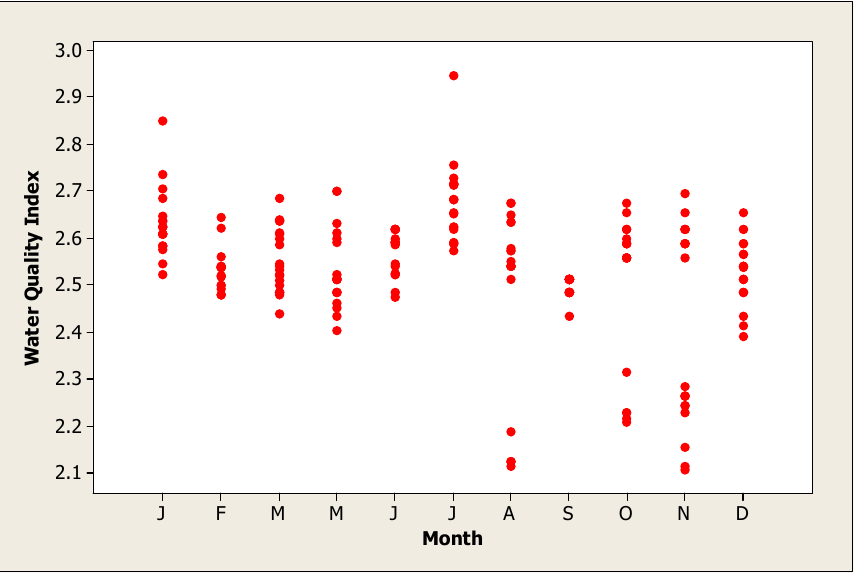
Figure 4. WQI values calculated during different months in the Luis L. Dam in Chihuahua, Mexico.